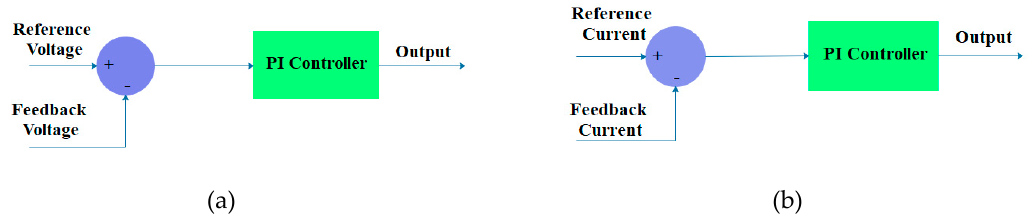
Figure 12. Block diagram of PI controller: ( a ) Voltage control; ( b ) current control.